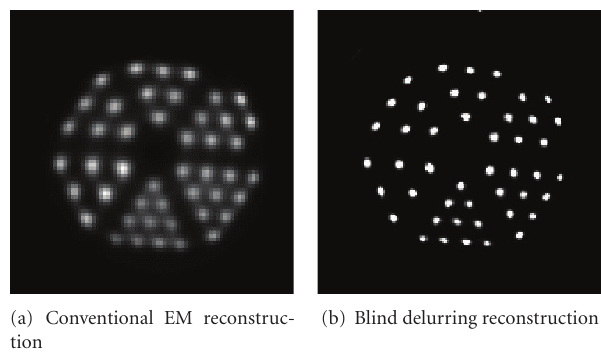
Figure 5: Slice from Jaszczak phantom